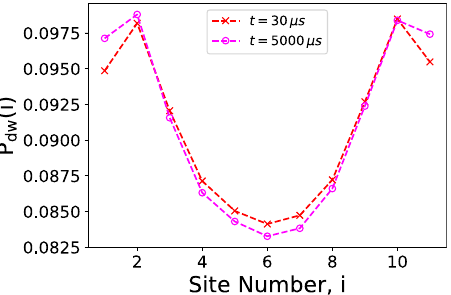
Fig. 5 Domain-wall distribution for a 12 qubit chain with two different anneal times. Standard error error bars are smaller than the depicted symbols. Background susceptibility corrections are not ¼ 0 : 2363 . Lines T